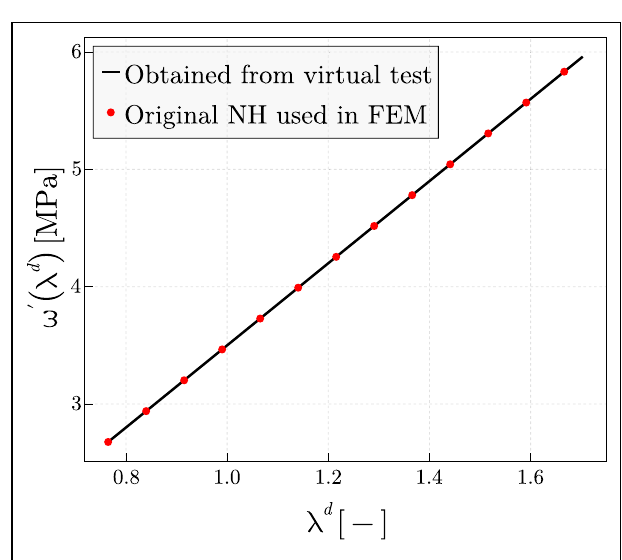
FIGURE 3 | Comparison of the Neo-Hookean ω ′ NH ( λ d ) and the ω ′ ( λ d ) obtained from the non-homogeneous virtual